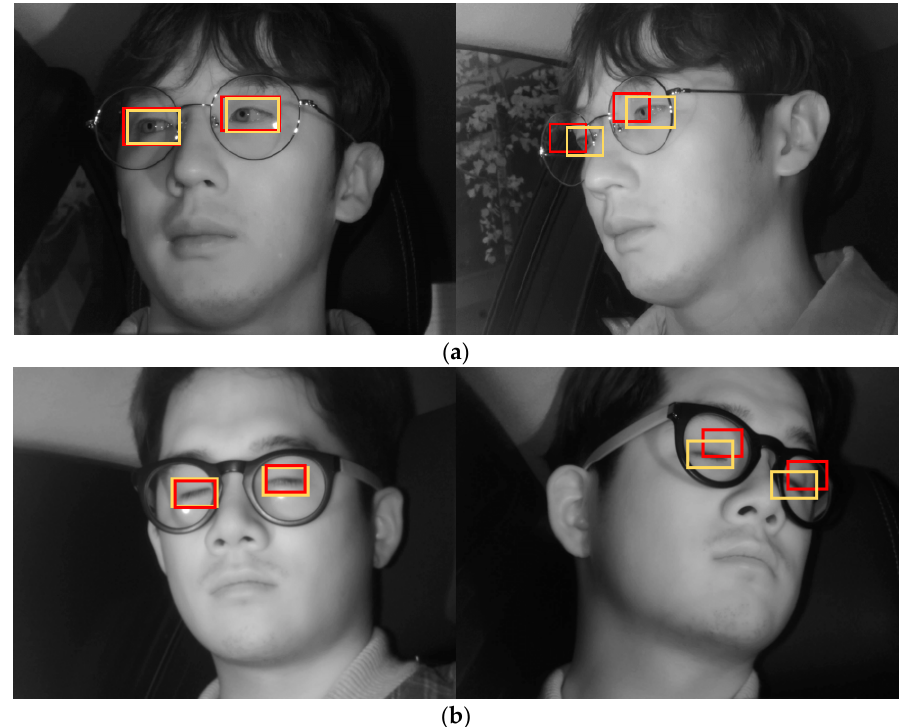
Figure 20. Examples of incorrectly detected eyes obtained using the proposed method: ( a ) open eye; ( b ) closed eye. (Yellow and red rectangles show the ground-truth and detected boxes, respectively).